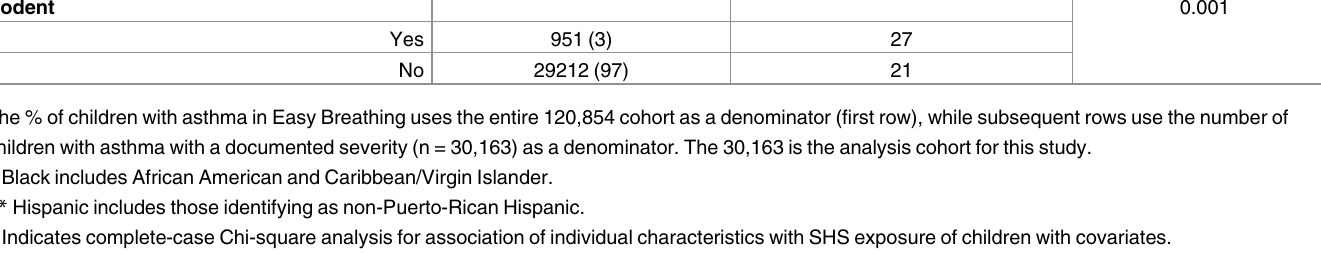
Table 3. Risk of exposure to SHS among children with asthma using Logistic Regression with Com- plete Case analysis.